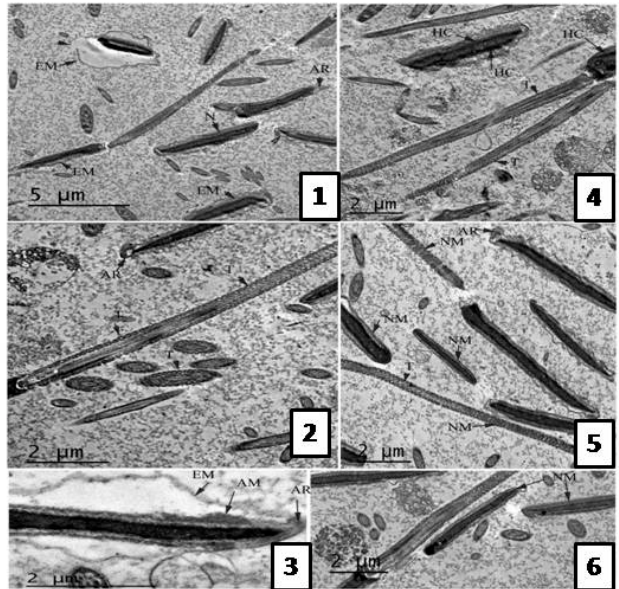
Figure 3. TEM photomicrographs of bull sperm head in groups treated with A. harveyi extract; ( 1 – 3 ) TEM photomicrographs treated with 0.5 mg/mL. Sagital sections for acrosomal region and mid piece showing extension of cell membrane (EM) with different degrees. Discontinuous membrane (DC) also observed. ( 2 ) Sagital section for neck region representing electron translucent (T) parts of mitochondrial sheath and unequal distribution. ( 3 ) Sagital section for acrosomal cap showing detached outer plasma membrane, diffusion of acrosomal material (AM) into subacrosomal space and apical ridge (AR) formation; ( 4 – 6 ) TEM photomicrographs treated with 1.0 mg/mL extract. ( 4 ) Sagital section from neck region showing heterogenous chromatin (HC) condensation in acrosomal region. ( 5 , 6 ) Different sagital sections from acrosom and neck region representing mild extension of cell membrane (EM) and apical ridge formation (AR). Also, mild degree of mitochondrial sheath damage was observed and some regions have translucent mitochondria while other regions have normal mitochondria (NM). Molecules 2017 , 22 , 1993